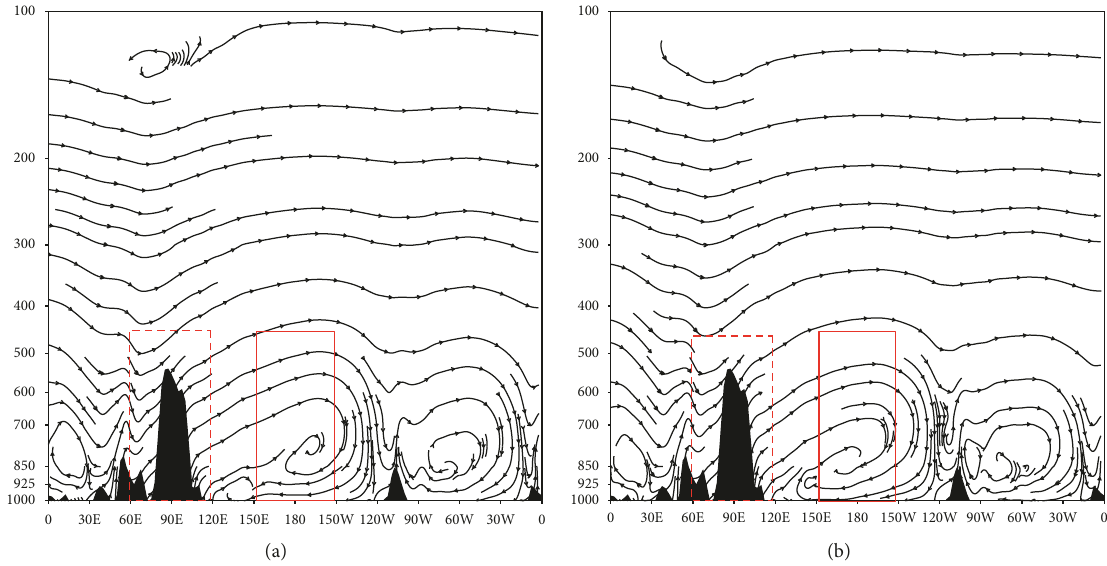
Figure 7: Longitude-height cross section of the climatology of vertical circulation along 15–50 ° N for (a) 1948–1990 and (b) 1991–2016. The black shaded area indicates the terrain.